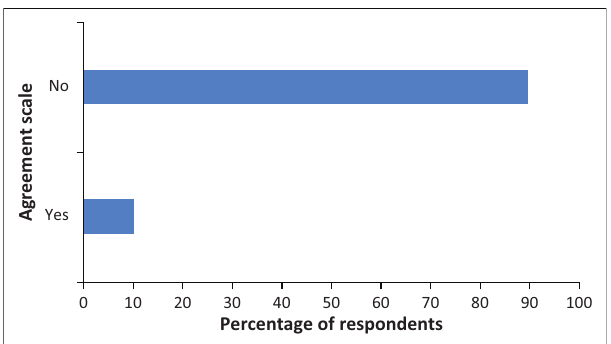
FIGURE 1: Have you ever been trained by government or private sector?